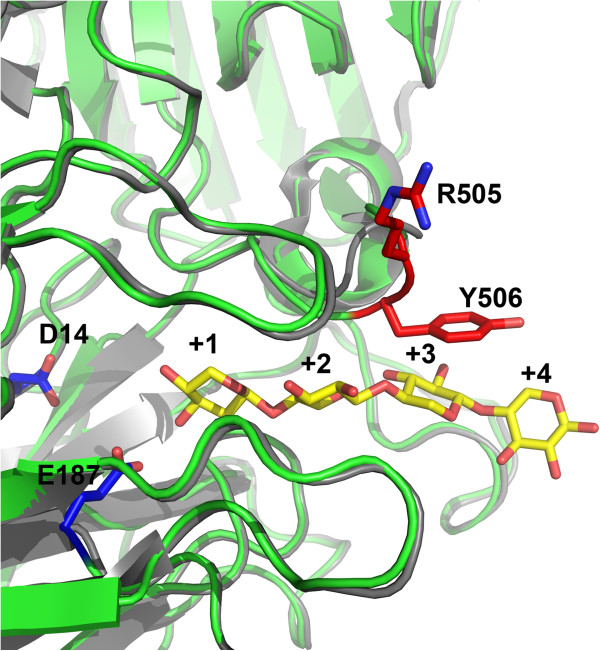
Model of BXA43 (green) superimposed with the structure of the close homolog XynB3 (grey, 2EXH), showing the two catalytic residues D14 and E187 (in blue; BXA43 numbering). Xylotetraose (yellow) was manually fitted from the structure of the complex with BsAXH-m2,3 on Bacillus subtilis (grey, 3C7G) (Vandermarliere et al., 2009) occupying the +1, +2, +3, and +4 subsites and illustrating a predicted +3 subsite involvement of Y506 (red). Arg505 in BXA43 may play a role in the positioning of Tyr506.